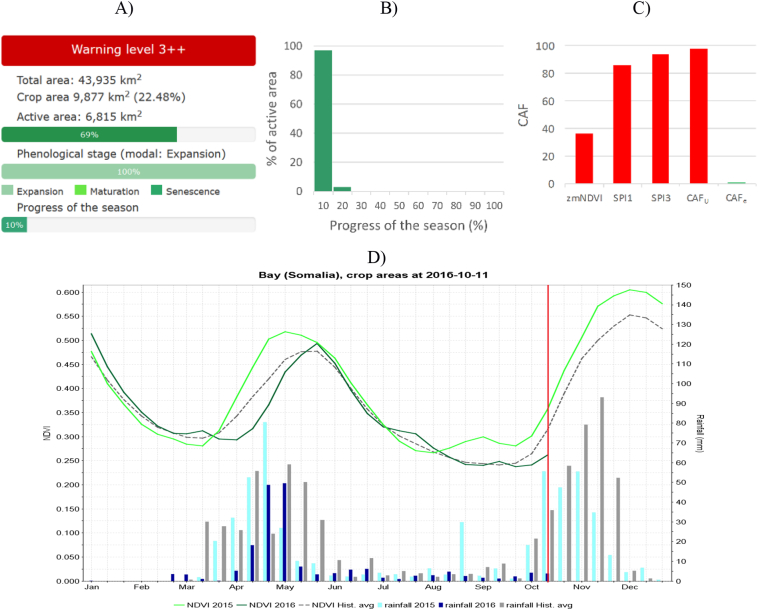
Statistics and graphs generated by the ASAP system on 20-Oct-2016 for the Bay unit of Somalia. A) Warning level details and summary statistics. B) Percentage of active area by progress of the season classes. C) Critical area fraction by indicator. D): Temporal profiles of rainfall and NDVI for the unit. Previous year (2015) and historical average (Hist. avg.) are reported for comparison. The vertical red line indicates the time of analysis (in this case 2nd dekad of October).